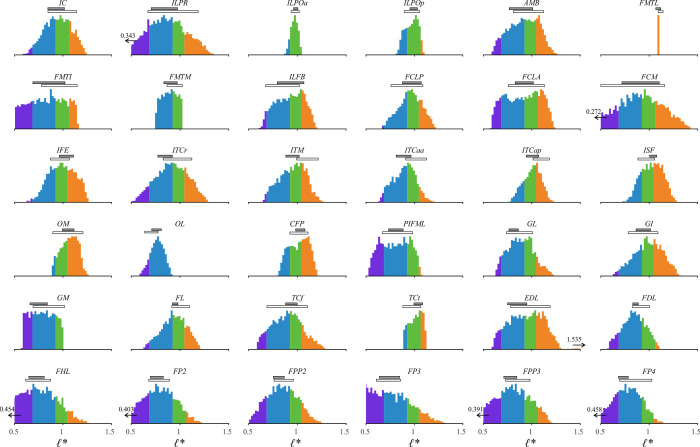
Distribution of normalized fibre lengths for each MTU in static simulation 1 (3,827 viable poses).Each distribution is visualized as a histogram (intervals of 0.02× ℓo), the vertical axis of which is scaled by the magnitude (number of counts) of the most frequent bin. Colours signify the various parts of the active force–length curve as per Figs 5 and 6. Also shown are the ranges of normalized fibre lengths used in vivo during walking (grey bars) and running (white bars). Instances where the minimum or maximum normalized fibre length achieved reached below 0.5 or above 1.5 (respectively) are indicated. The very small range recovered for the FMTL is due to the way its path was represented in the musculoskeletal model, crossing over the lateral femoral condyle close to the flexion–extension axis of the knee, such that it had little opportunity to undergo change in MTU length in the first instance. Similarly, the small range recovered for the ILPOa likewise reflects its path in the model passing close to the flexion–extension axes of the hip and knee. See Table 2 for muscle abbreviations.